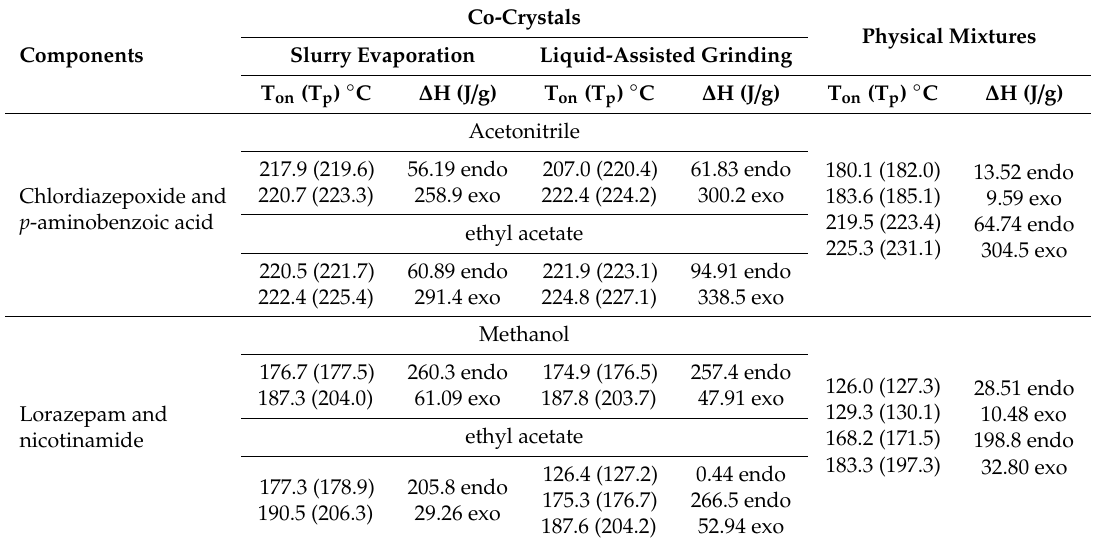
Table 2. Thermal data acquired from di ff erential scanning calorimetry (DSC) curves for benzodiazepines co-crystals prepared using di ff erent co-crystallization methods and solvents, and for physical mixtures of benzodiazepines and